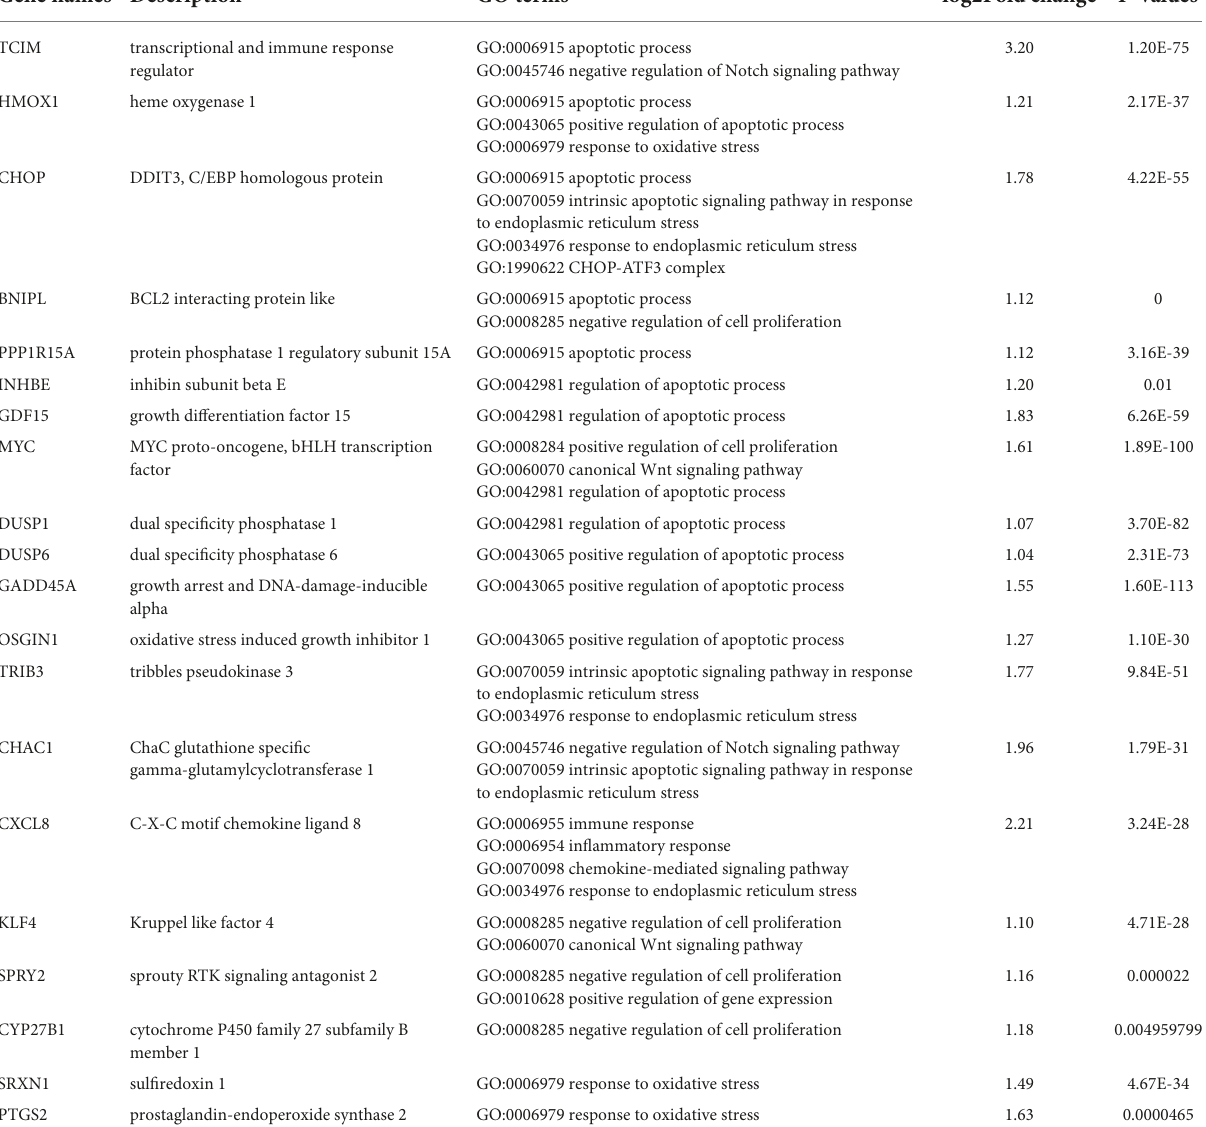
TABLE 3 Mostly upregulated enriched 20 DEGs in M. bovis P150 infected BoMac compared to P1